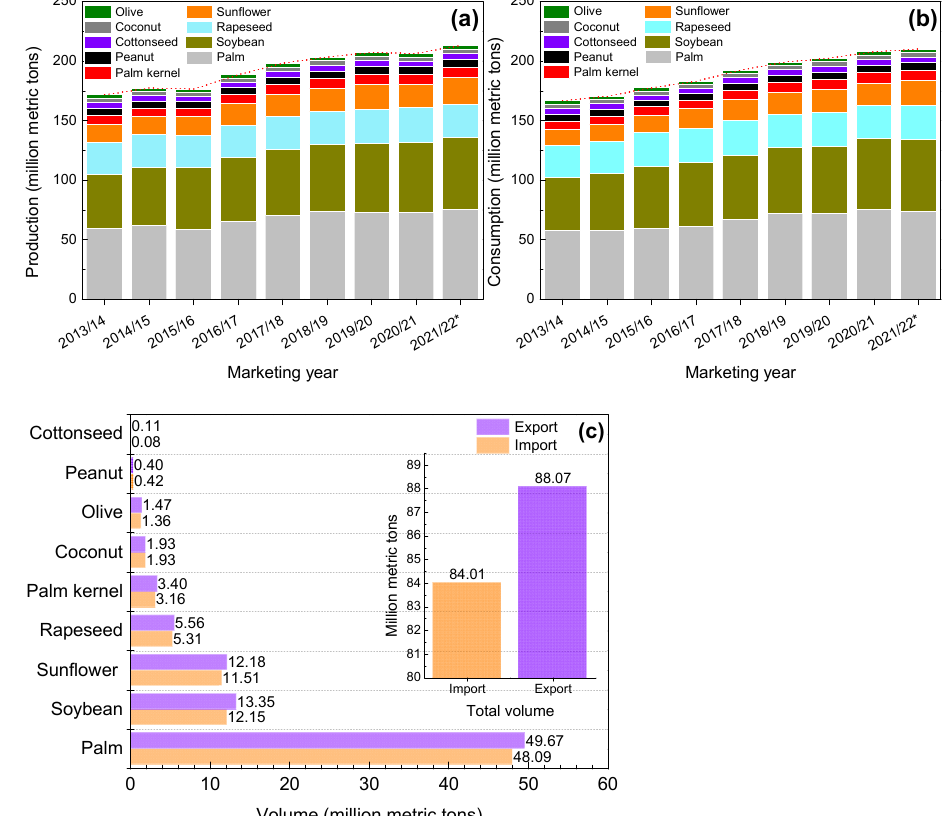
Figure 1. Global production ( a ) and consumption ( b ) of vegetable oils from 2013 to 2021, and the import and export volumes of major vegetable oils worldwide in the 2021/2022 marketing year ( c ). * Expected production/consumption. Adapted from Refs. [1,4–6]. 2022, Statista.